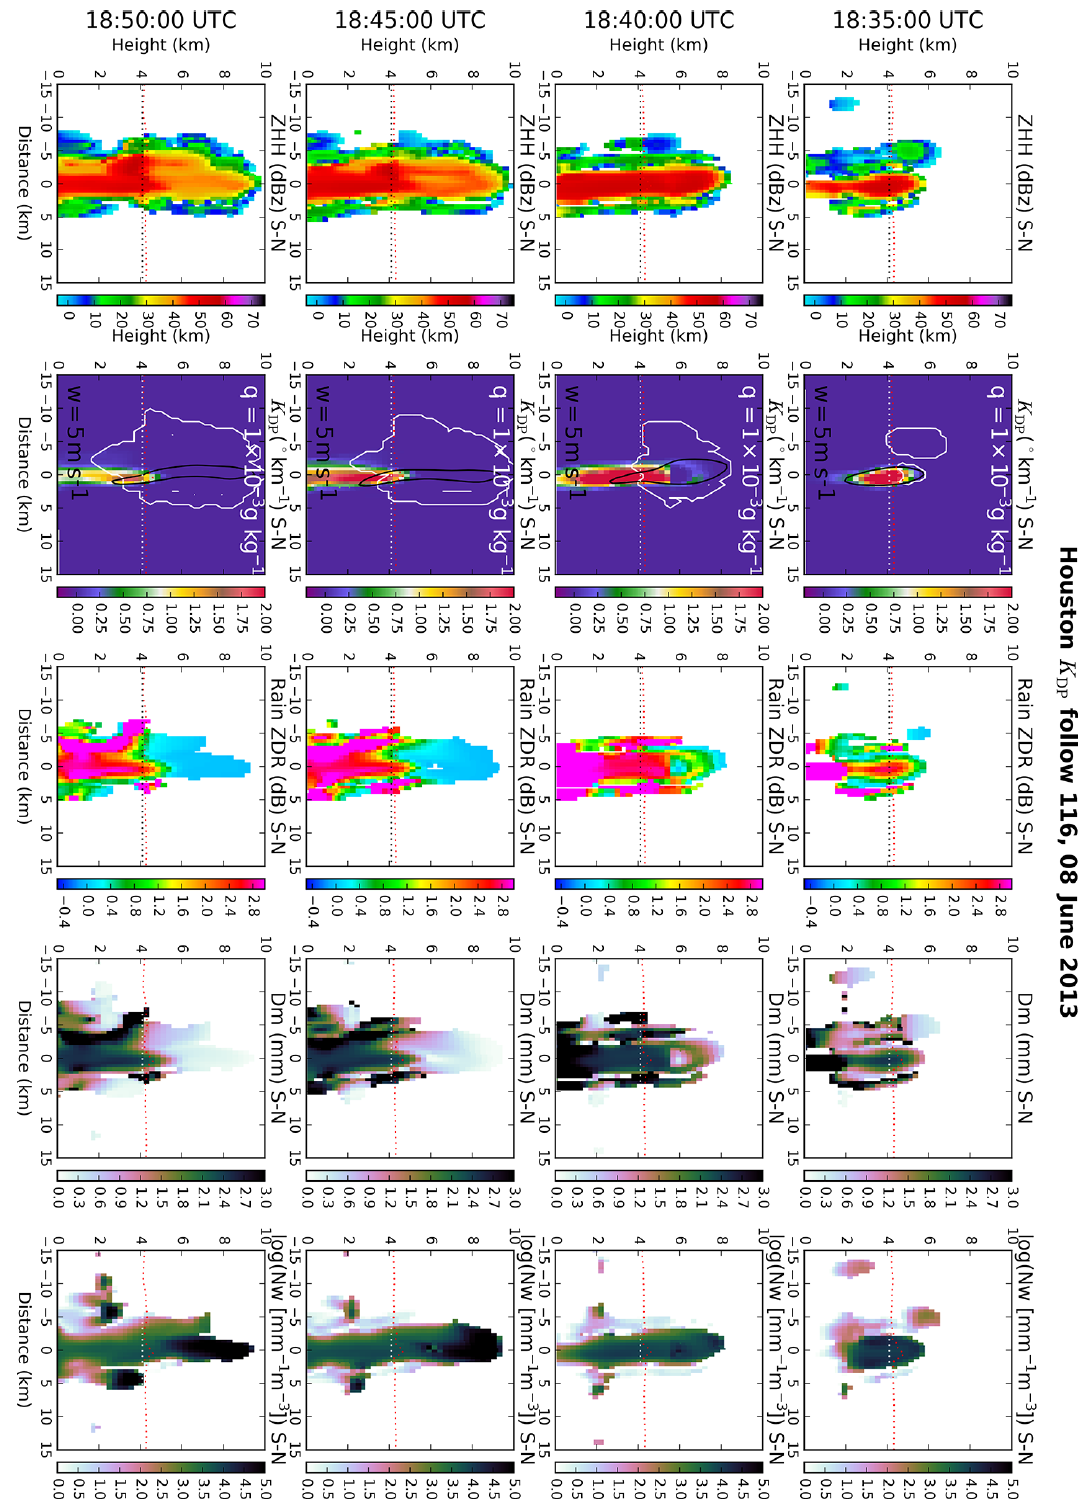
Figure 8. Sequential south–north cross sections from tracked K DP column 116 show (left to right) calculated Z HH , K DP with overplotted contours of updraft strength ( w ) greater than 5ms − 1 and total ice mixing ratio ( Q i ) greater than 0.001gkg − 1 , Z DR , and raindrop D m and N w . In all panels the melting level averaged over the inner domain and at a single point (similar to a sounding) are shown by red dotted and black dotted lines, respectively. Full time series shown in Fig.